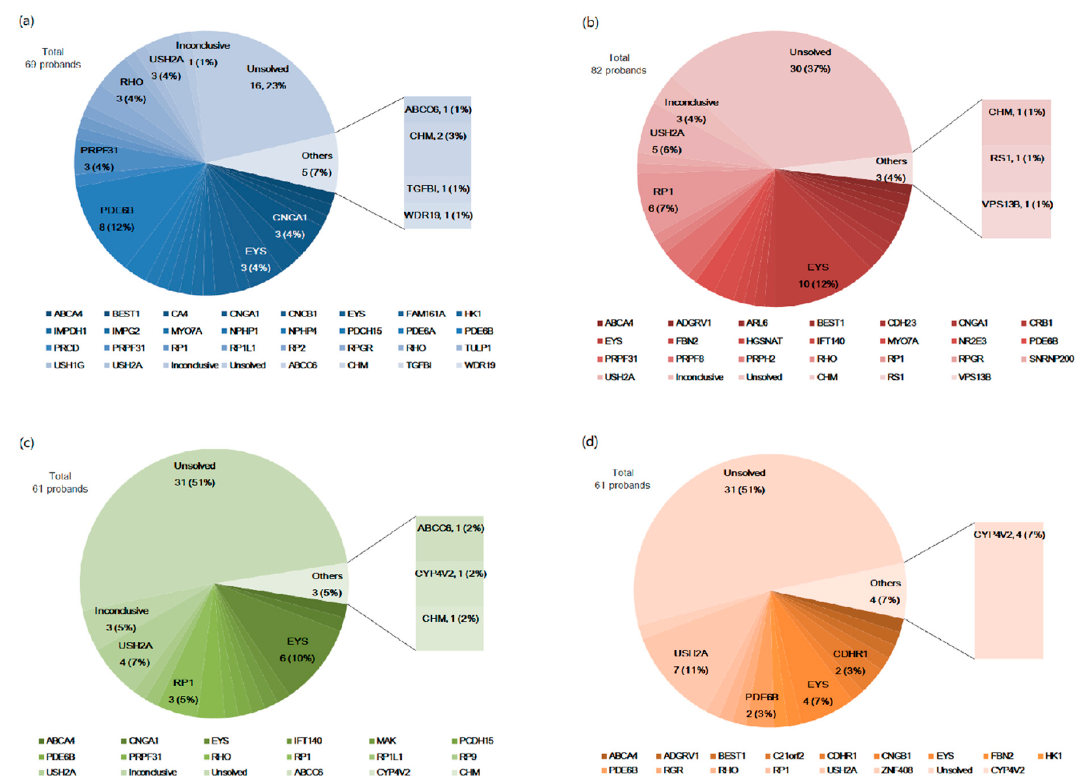
Figure 3. Mutational spectra of 279 probands with retinitis pigmentosa according to age at symptom onset. ( a ) Mutational spectrum for age at symptom onset under 10 years. ( b ) Mutational spectrum for age at symptom onset between 11 and 20 years. ( c ) Mutational spectrum for age at symptom onset between 21 and 40 years. ( d ) Mutational spectrum for age at symptom onset over 41 years.